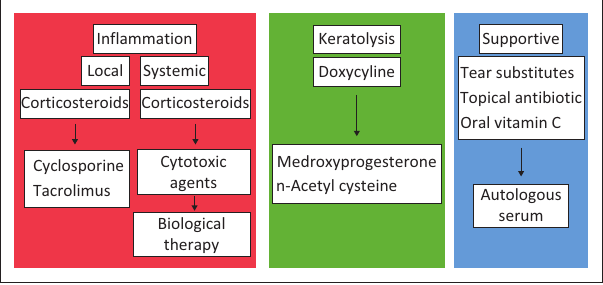
FIGURE 4 : Stepladder approach to the medical management of autoimmune associated peripheral ulcerative TABLE 2: Cytotoxic agents for the management of autoimmune peripheral ulcerative keratitis. Agent Mechanism of action